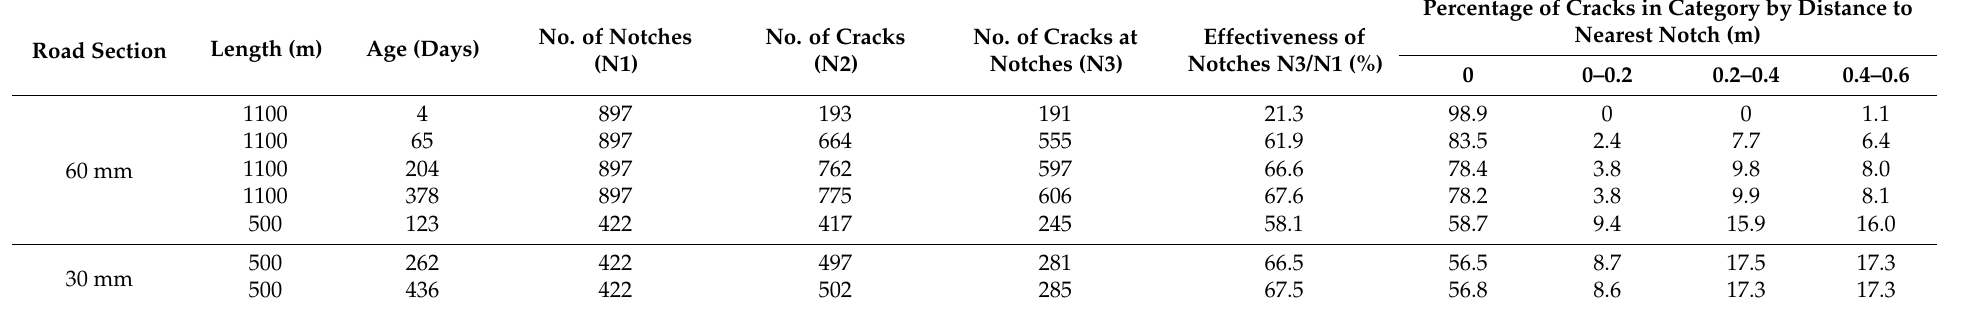
Table 2. Active crack characteristics on the Motorway E313 section